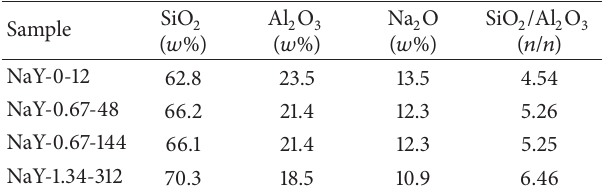
Table 1: The element content and SiO 2 /Al 2 O 3 measured by